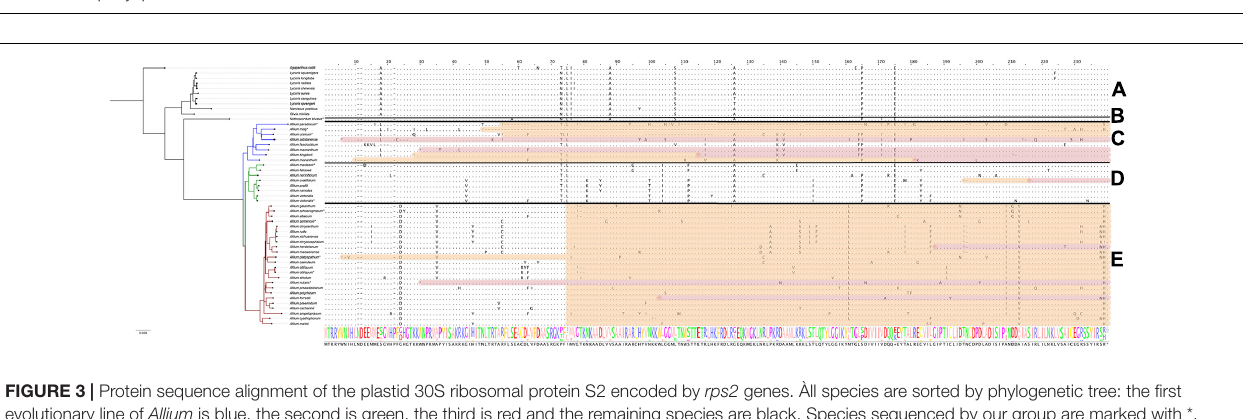
FIGURE 2 | Protein sequence alignment of the plastid 30S ribosomal protein S16 encoded by rps16 genes. Àll species are sorted by phylogenetic tree: the first evolutionary line of Allium is blue, the second is green, the third is red and the remaining species are black. Species sequenced by our group are marked with *. (A) Shows Agapanthoideae and Amaryllidoideae subfamily species; (B) shows Nothoscordum bivalve as an outgroup for Allium genus; (C) shows the first evolutionary line Allium species; (D) —the second and (E) —the third. Non-conserved AA positions are highlighted as letters and conserved as dots. The whole AA sequence is shown as a normalized alignment logo below. Possible frameshifts are shown as! and stop codons as *. Damaged sequences are highlighted in peach color in case of frameshift, in purple in case of stop codon and in red in case of total AA loss. Colored sequences may be assumed to be a pseudogene. The gene is absent in A. platyspathum .